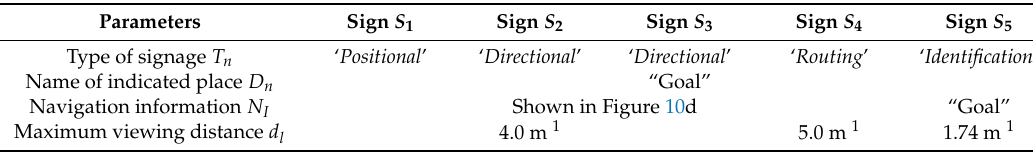
Table 5. User-assigned parameters of signage information.